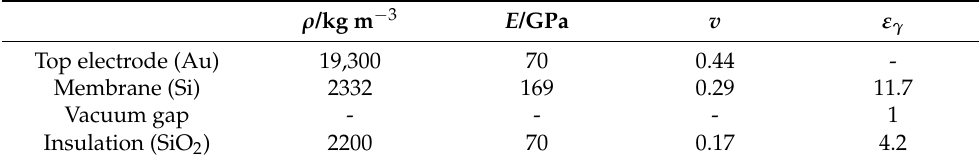
Table 1. Properties of materials in the finite element model (FEM).